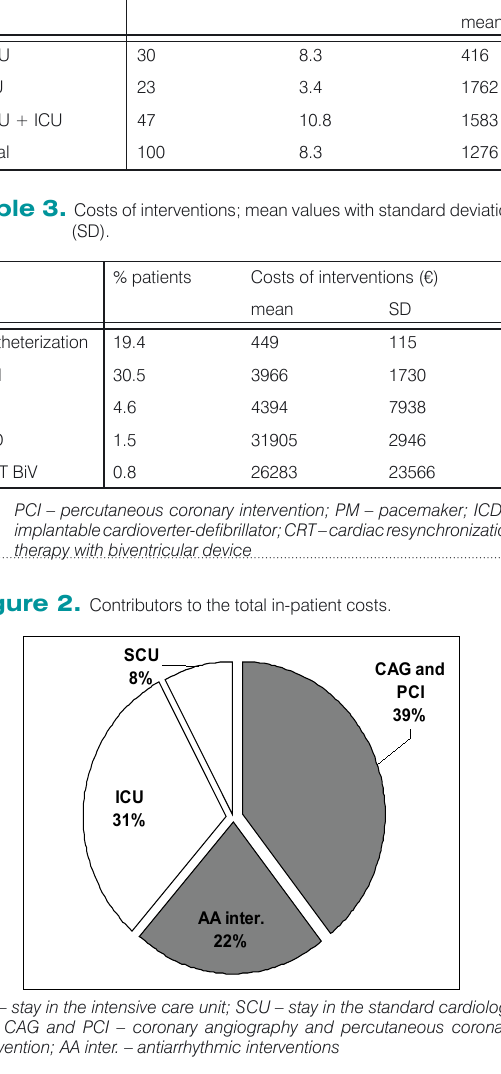
Table 4. Total costs and length of stay by clinical characteristics of